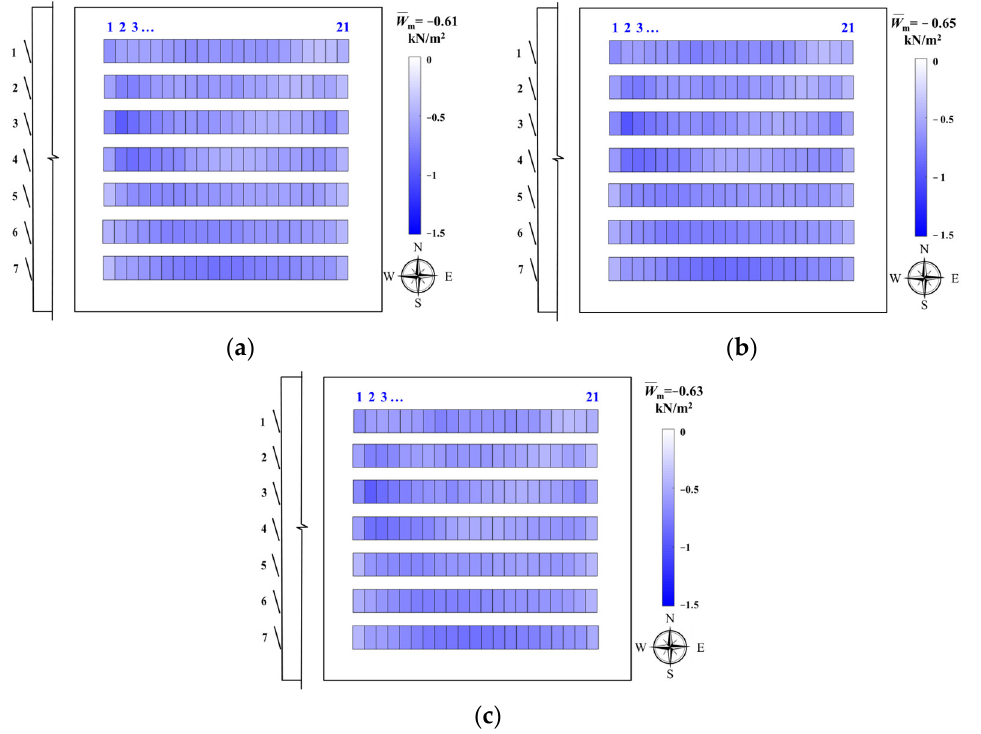
Figure 8. Distributions of extreme wind loading W m on the solar arrays with building orientation α = 0° in Jinan, China, given different extreme wind loading coefficients : ( a ) 57% percentile C 57% ; ( b ) 78% percentile C 78% ; and ( c ) Random wind loading coefficient C r .